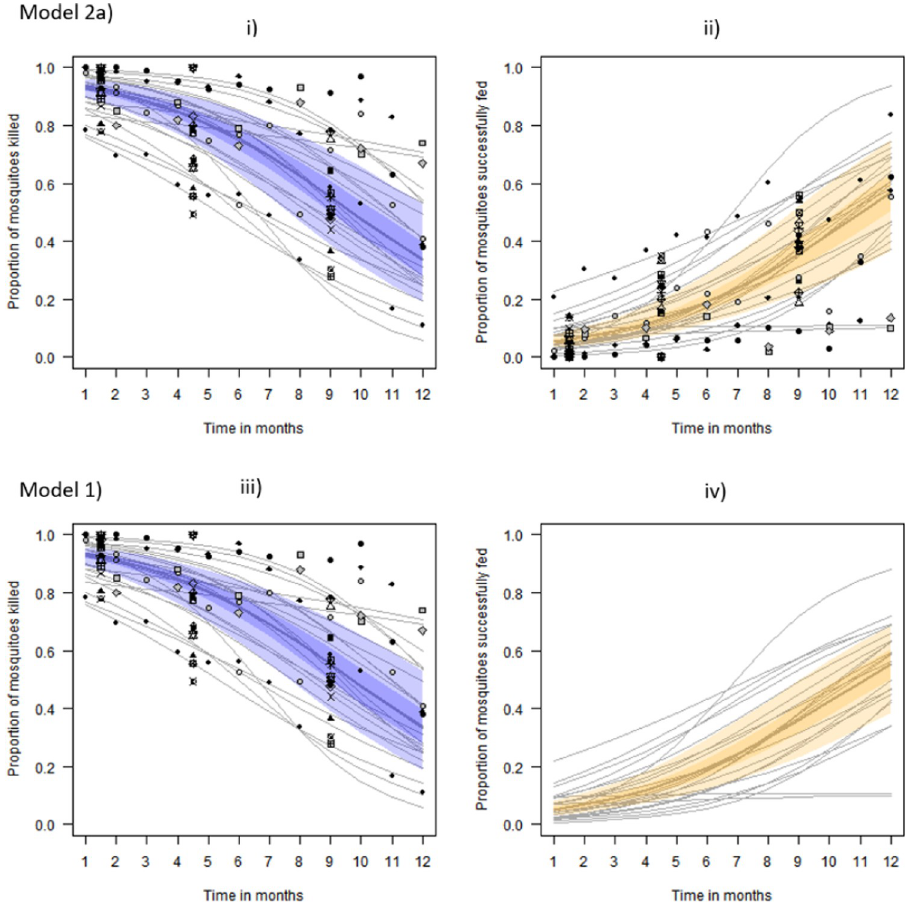
Fig 3. Model predictions of proportion of mosquitoes killed and successfully fed. For the best-estimate (median posterior predictive value) across all aggregate datasets, 50% (darker shaded region) and 95% (lighter shaded region) credible intervals (CrI) from the respective fits to aggregated data. Subfigures i) and ii) show results in the case of empirically disaggregating the blood fed data before fitting the model (Model 2a), and subfigures iii) and iv) show results for the case of taking this step after model fitting marginal probabilities. Data for the fits are overlaid onto the figure to demonstrate the suitability of the time-dependent functions. In each of the fits, the individual study predictions are overlaid on the figures by thin grey lines and noted by matching symbol type for each timeseries. In iv) the model was not fit to successfully fed data so has no overlaid points. Anopheles gambiae s.l. (circles), An . funestus s.l. (squares) and An . arabiensis (triangles) mosquitoes are noted. The data from the comprehensive source are only used in aggregated format.